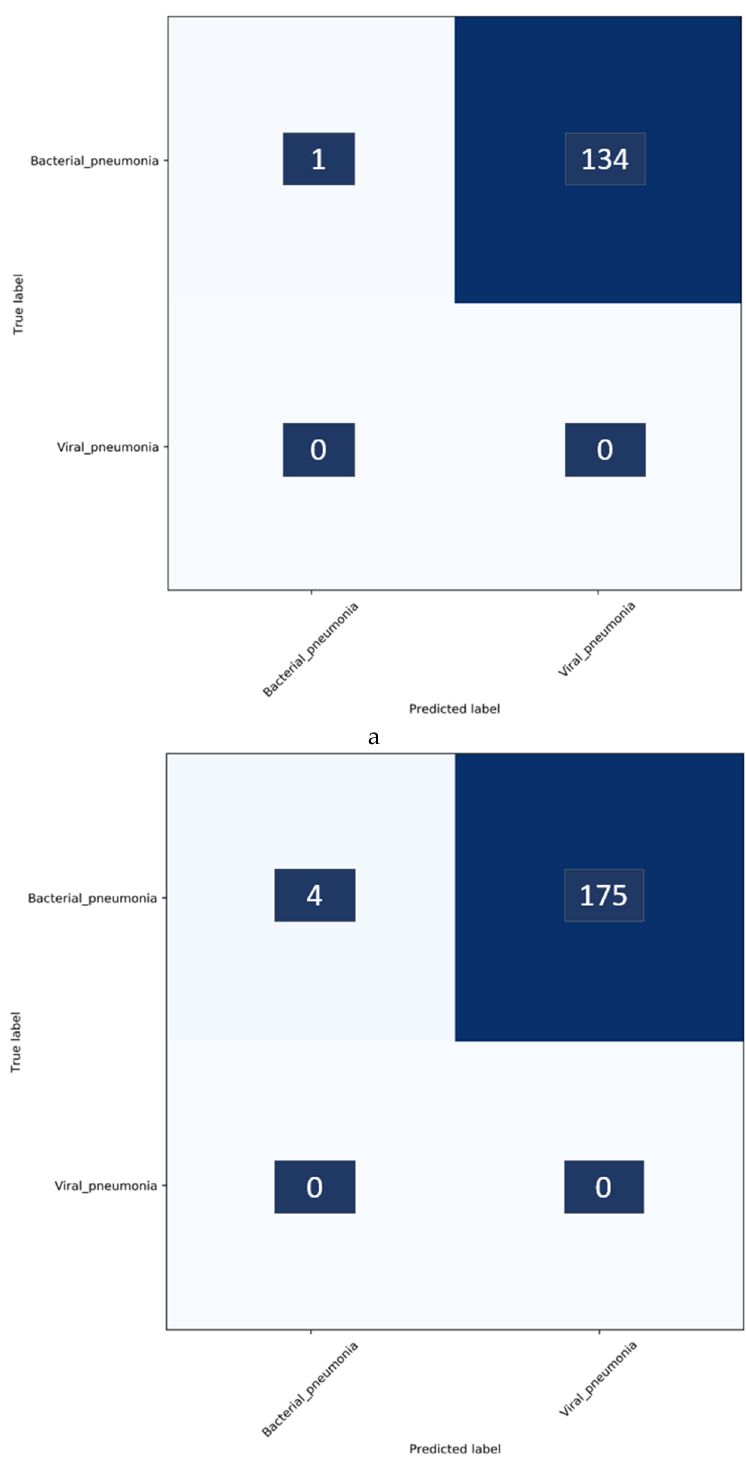
Figure 7. Confusion matrix after classifying bacterial and viral pneumonia in the ( a ) Twitter- and ( b ) Montreal-COVID-19 CXR collections after augmenting the baseline training data with individual COVID-19 CXR collections. Enlarged text labels have been manually superimposed for clarity.